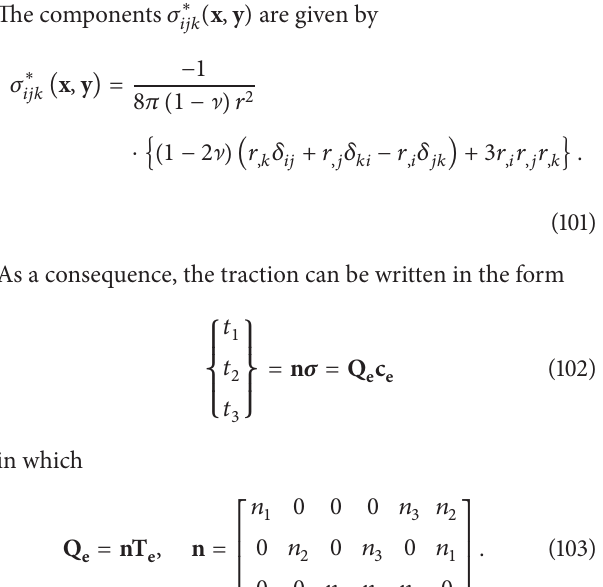
The components 𝜎